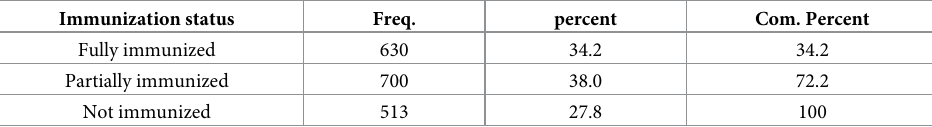
Table 1. Proportions of immunization status among children aged between 12–24 months, EMDHS 2019 ( n = 1 , 843